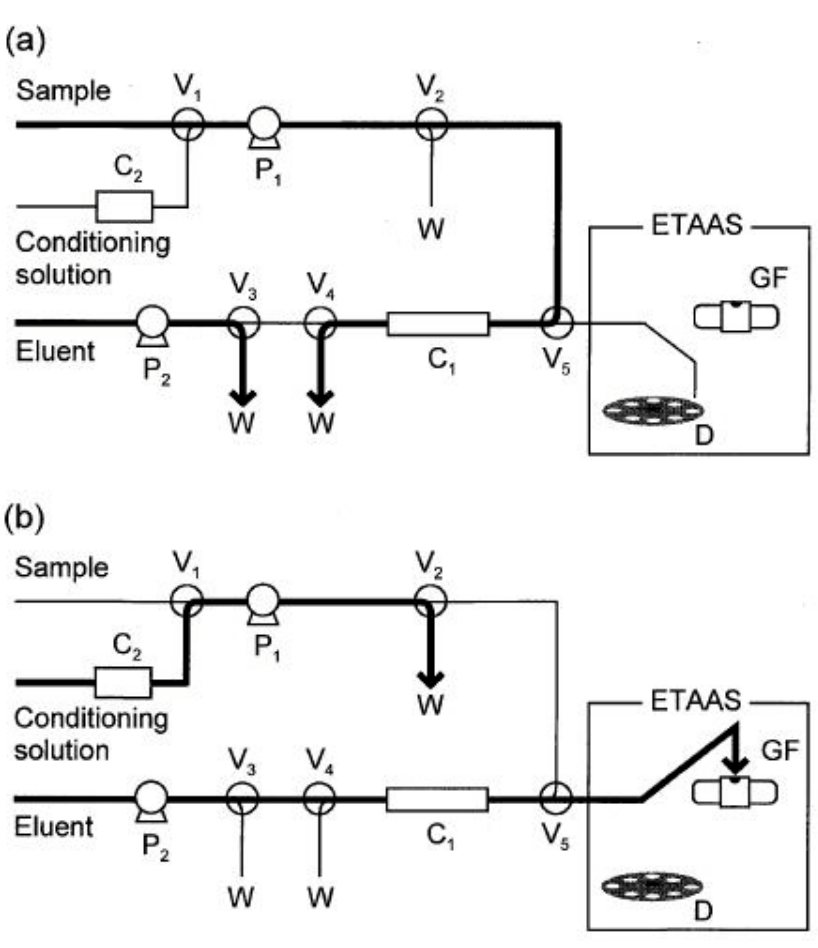
Figure 3 Flow-injection manifold for the determination of lead by an online-preconcentration – ETAAS analysis. (a) Sample loading; (b) elution, C P -P , peristaltic pump; GF, graphite furnace; W, waste; D, autosample 1 2